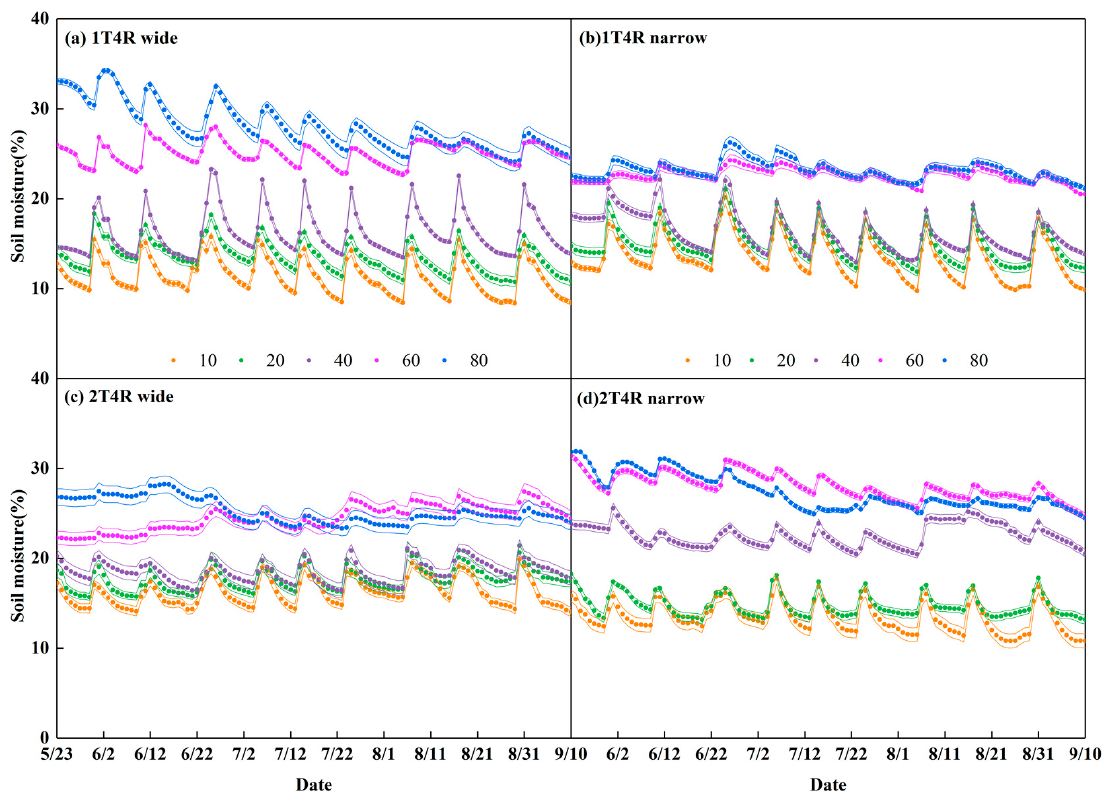
Figure 4. Dynamic changes in soil moisture under different drip irrigation treatment conditions in 2018a. ( a ) 1T4R wide, ( b ) 1T4R narrow, ( c ) 2T4R wide, ( d ) 2T4R narrow.